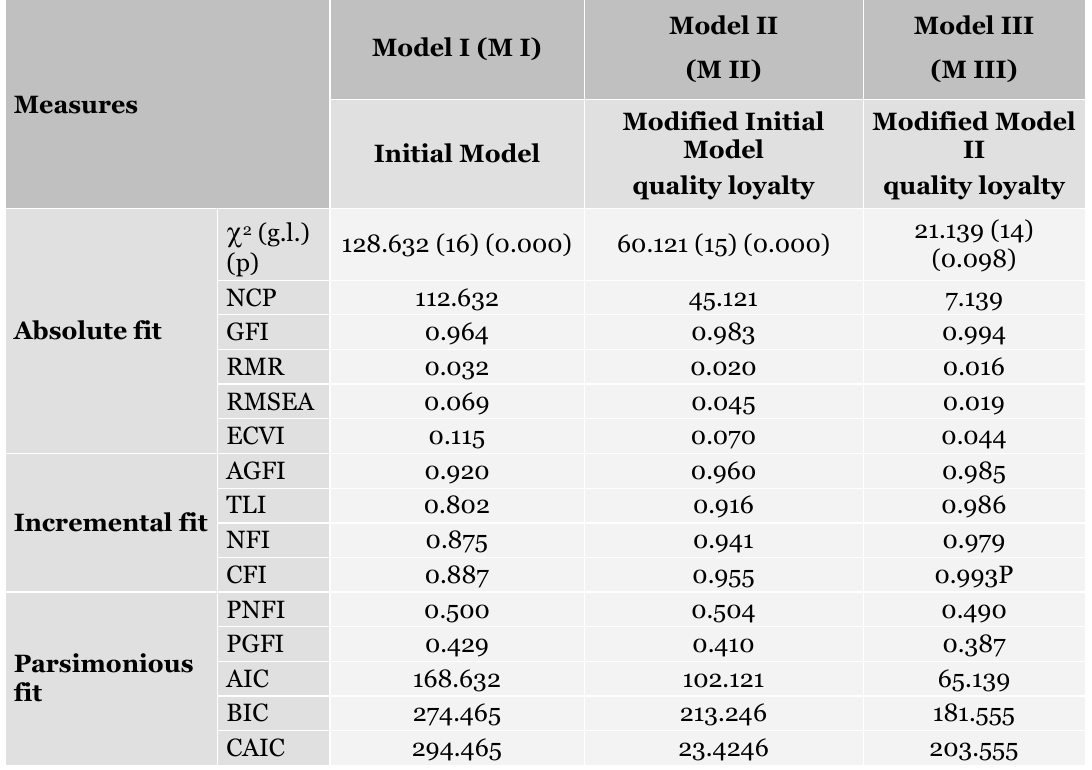
Comparative Structural